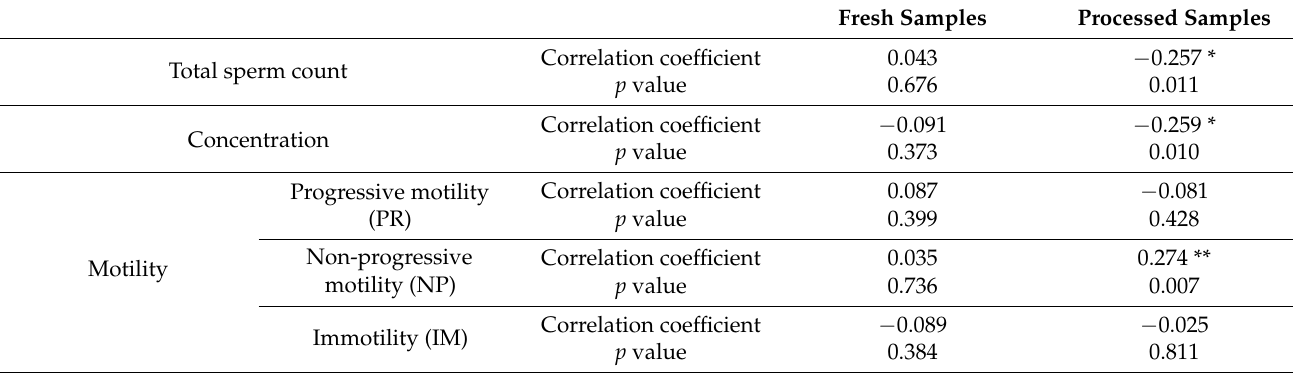
Table 2. Correlations between PRR with human sperm fertility status. Fresh Samples Processed